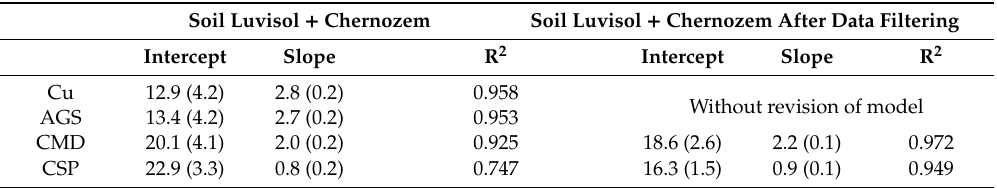
Table 3. Slopes and intercepts including their standard deviations (in brackets) estimated for merged soil data and sensor elements. Soil Luvisol + Chernozem